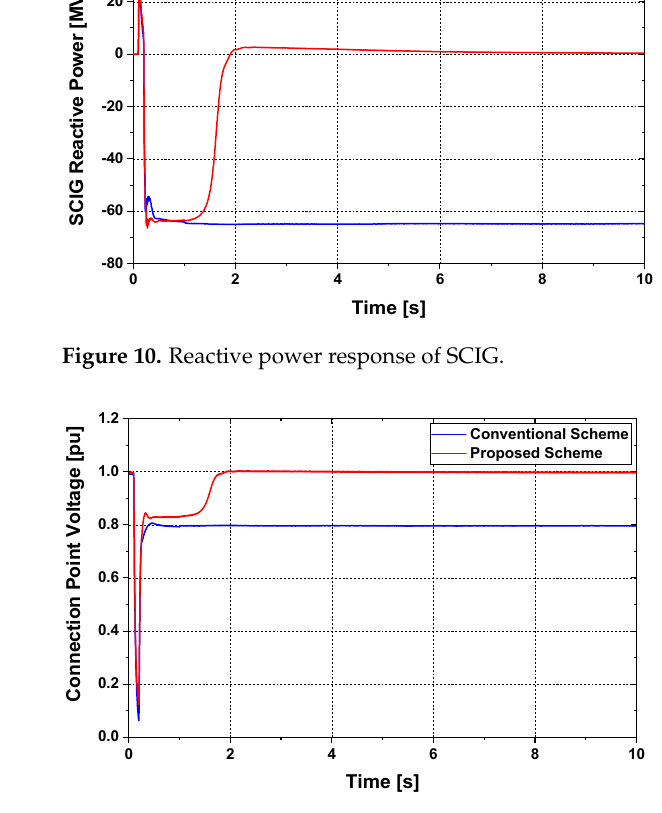
Figure 13. Reactive power response at the connection point. Figure 14. Active power response at the connection point. Figures 15 and 16 represent the response of active power of SCIG and DFIG, respec- tively, where Case 2 showed better performance. Figure 17 illustrated the rotor speed re- sponse of DFIG.